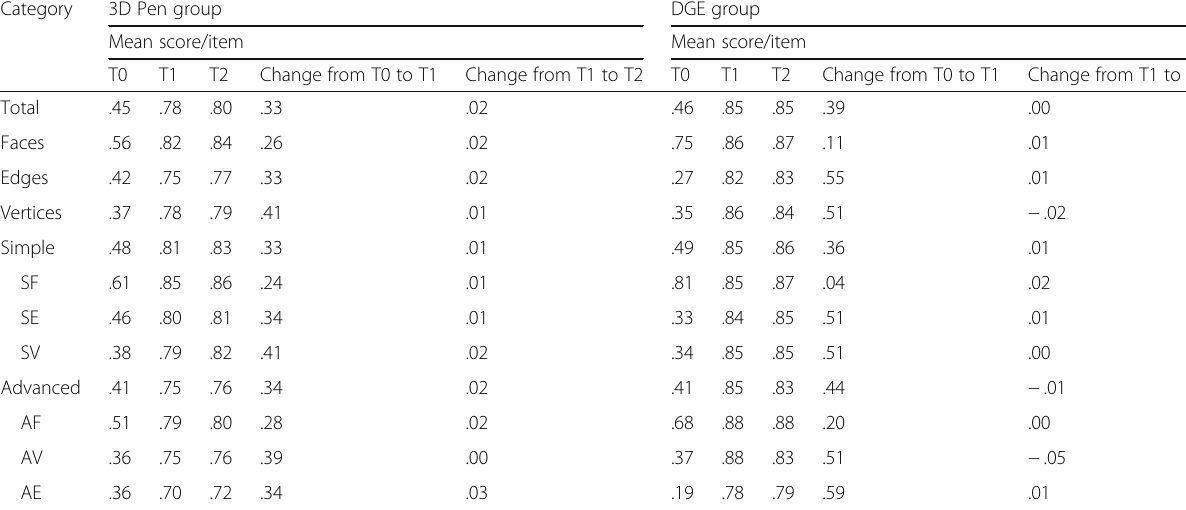
Table 2 Development of student scores from pretest to delayed